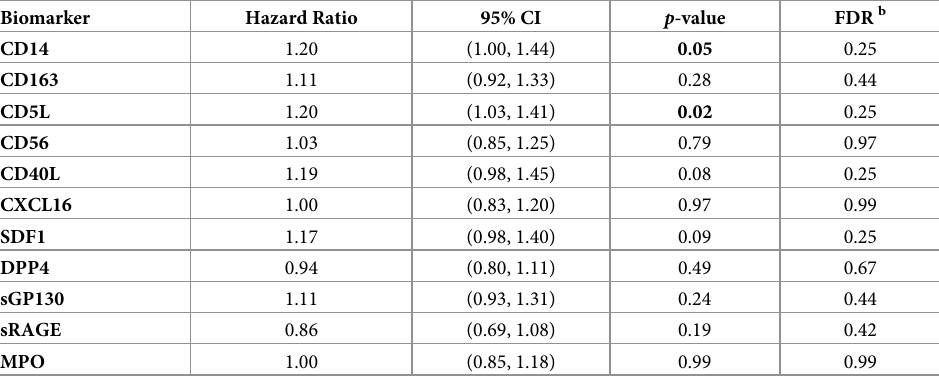
Table 2. Association of protein biomarkers with incident all-cause dementia within 10 years of follow-up a .